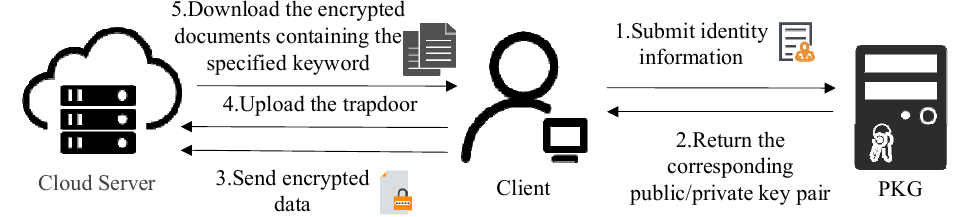
Figure 3. Model of entities and data interaction.